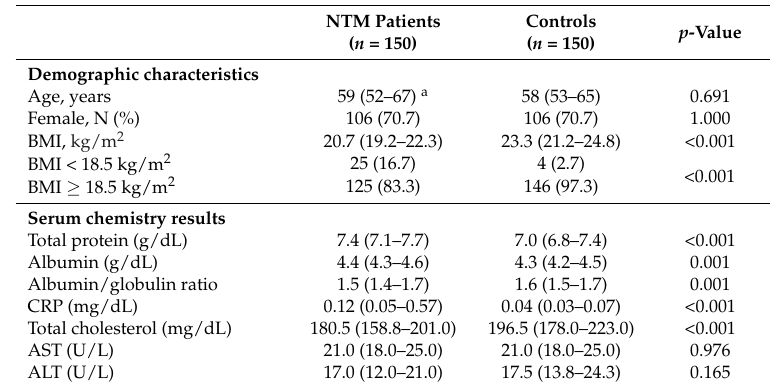
Table 1. General characteristics of the study